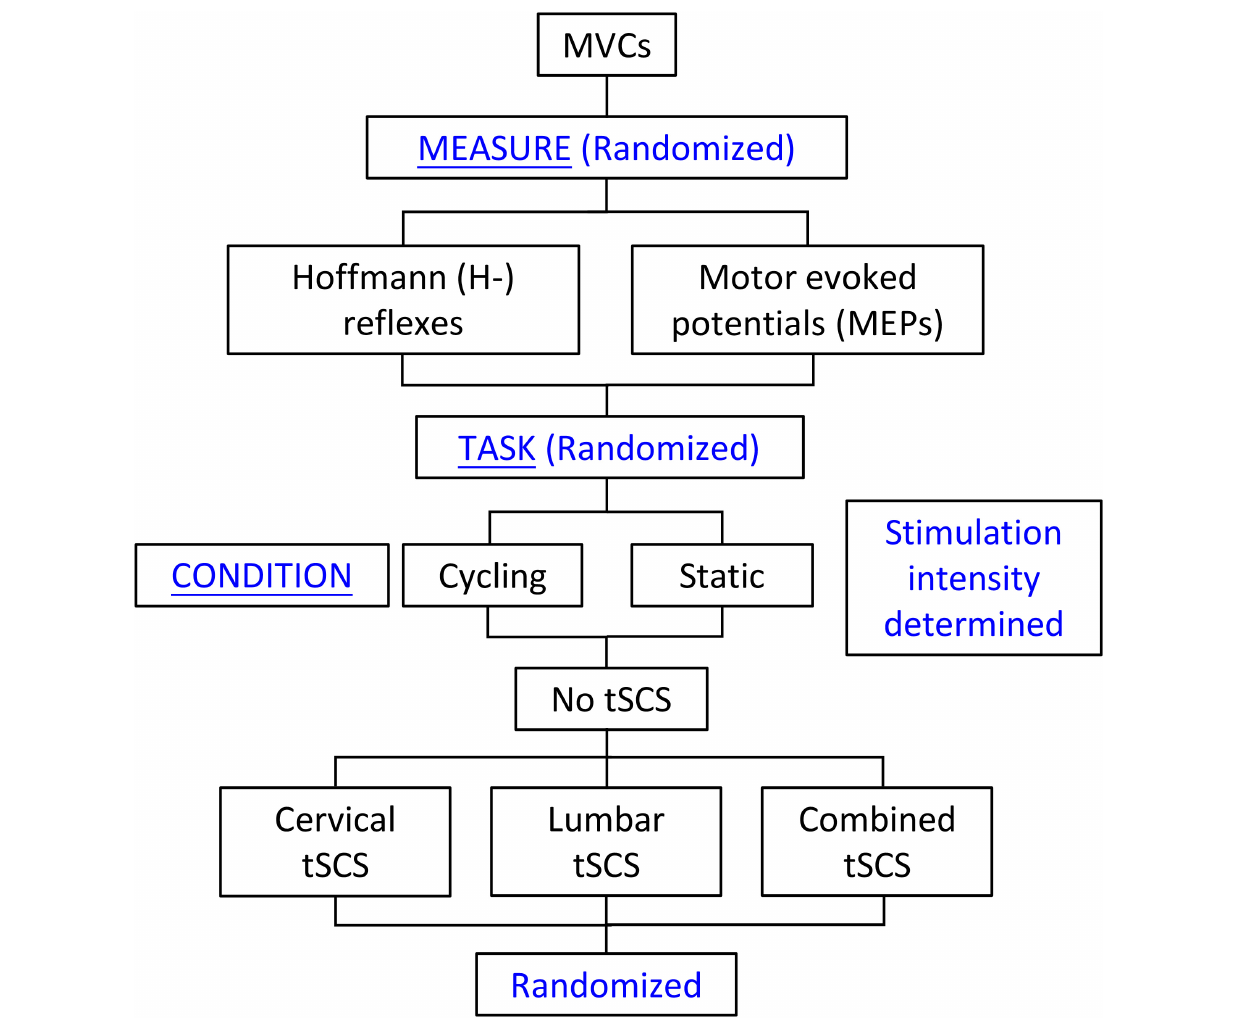
FIGURE 1 | Study design. Maximal voluntary contractions were collected and amplitudes of cervical and lumbar tSCS were determined at the beginning of each experiment. This was followed by random selection of the Hoffmann (H-) reflex or motor evoked potential (MEP) measures. The cycling or static tasks were then randomly selected. For each of these tasks, the No-tSCS condition was tested first, followed by random selection of the remaining conditions (Cervical tSCS, Lumbar tSCS, and Combined tSCS). The No tSCS condition was completed first in order to obtain the stimulation amplitudes to the median nerve and TMS needed to evoke the H-reflex and MEP, respectively, to be used across all